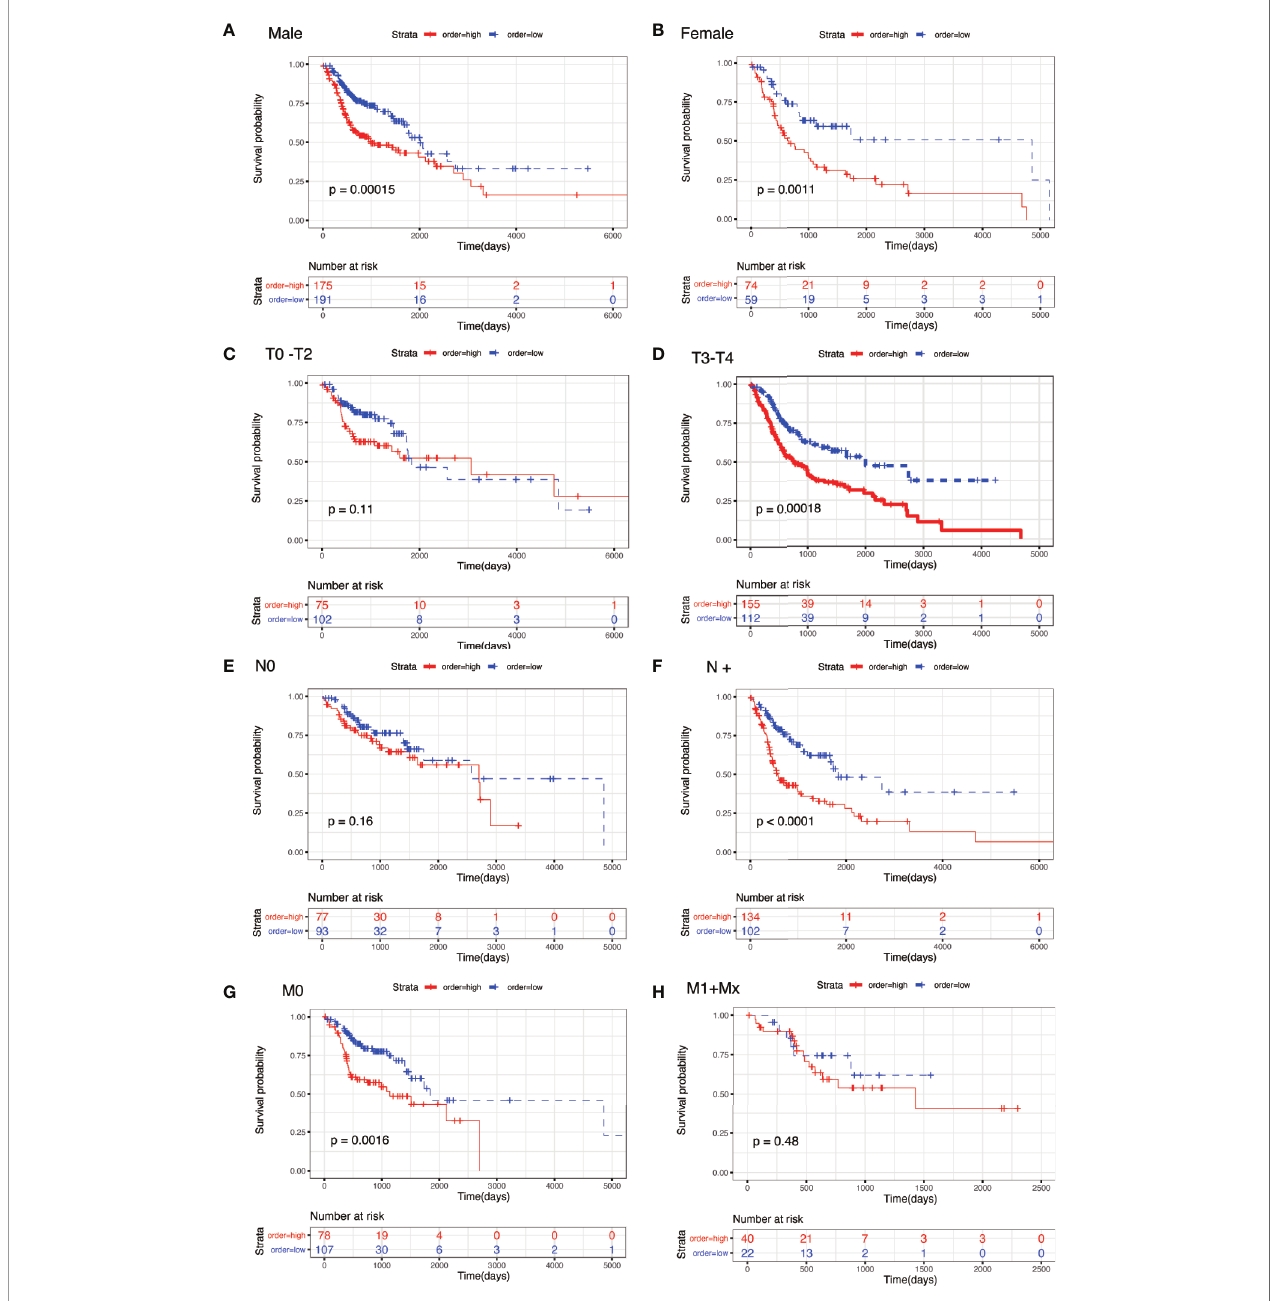
FIGURE 6 | KM survival subgroup analysis for all patients with HNSC according to the eight-gene signature strati fi ed by clinical characteristics. (A) male. (B) female. (C) T0 – T2. (D) T3/T4. (E) N0. (F) N+. (G) M0. (H) M1 +